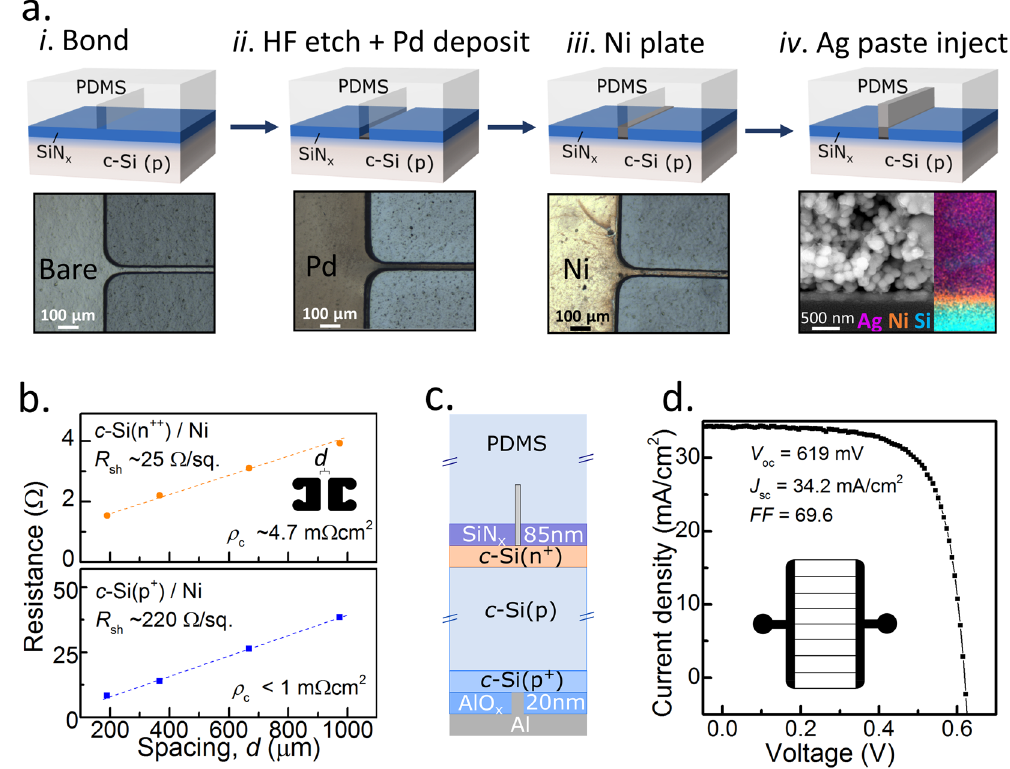
Figure 3. Electroless plating within the microchannel. ( a ) Nickel electroless plating procedure used in this study, for steps i - iii a top-view optical microscope image is provided, and for step iv a cross sectional SEM image with accompanying EDX mapping of local Ag, Ni and Si concentration is included. ( b ) Contact resistivity extraction of Ni plated layer on n ++ (top) and p + (bottom) surfaces. Planar heterojunction solar cell ( c ) layer design; and ( d ) 1 sun JV